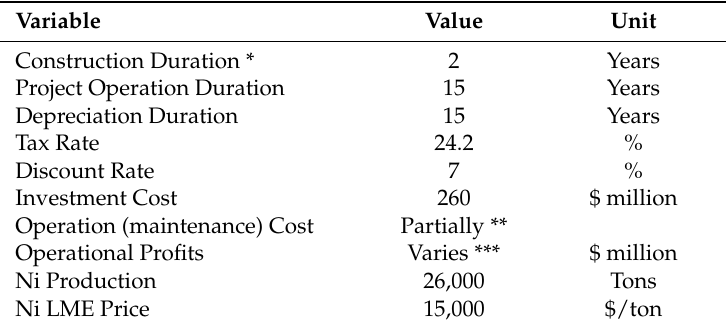
Table 4. Assumptions for Economic Analysis.